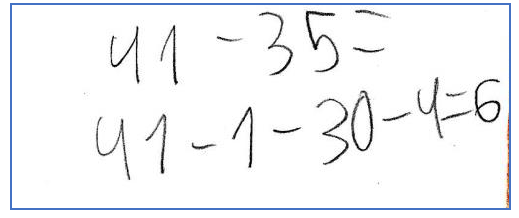
Figure 33. Work out 41 − 35.